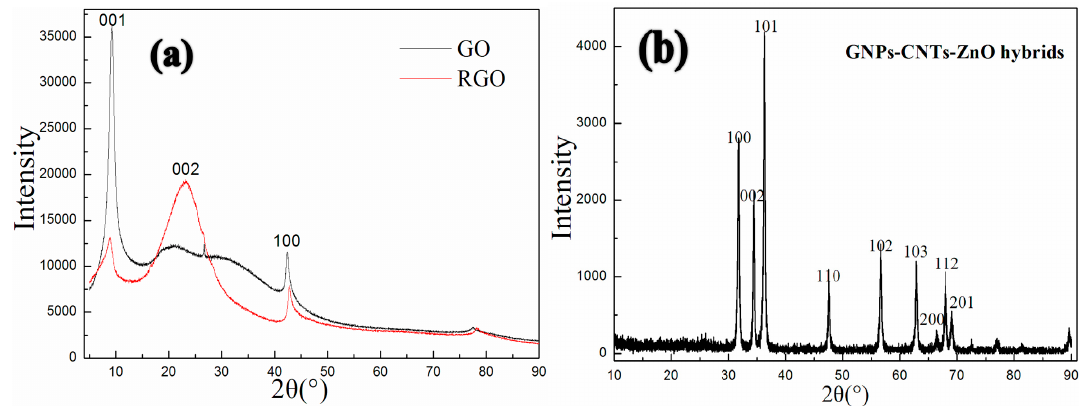
Figure 6. XRD spectrums of GO, RGO ( a ) and GNPs-CNTs-ZnO hybrid ( b ).